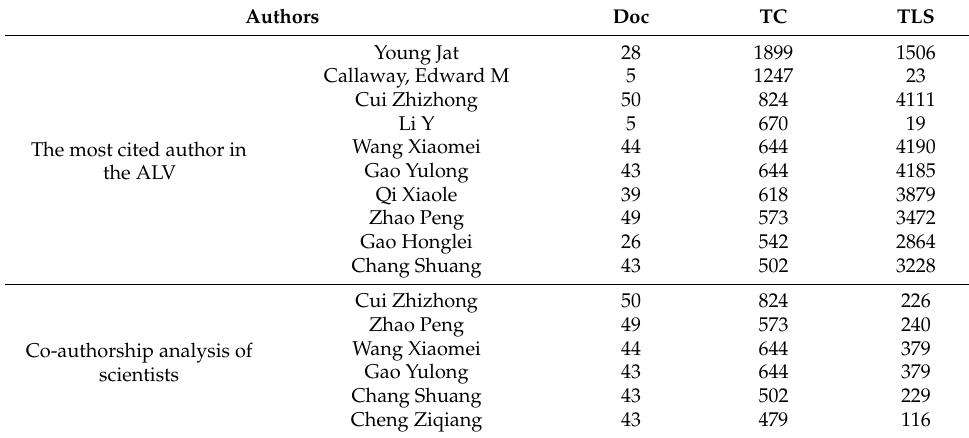
Table 5. Top ten cited authors in the ALV